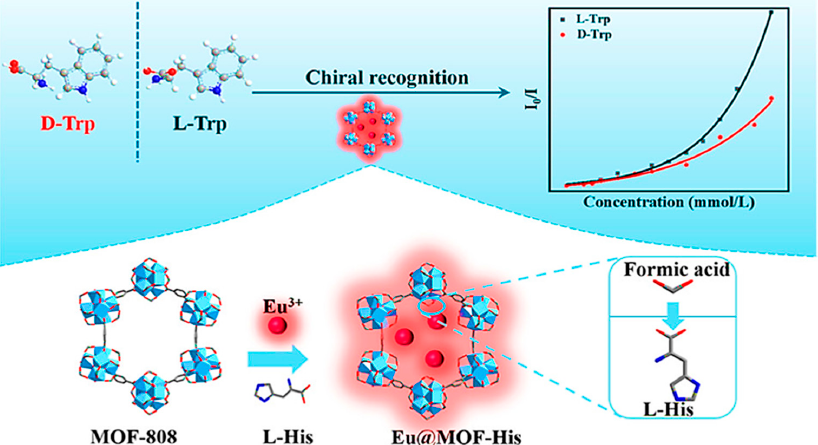
Figure 4. Preparation steps and application of Eu@MOF-His for fluorescence enantioselective sensing of tryptophan. Reprinted (adapted) with permission from [60]. Copyright 2022 American Chemical Society.